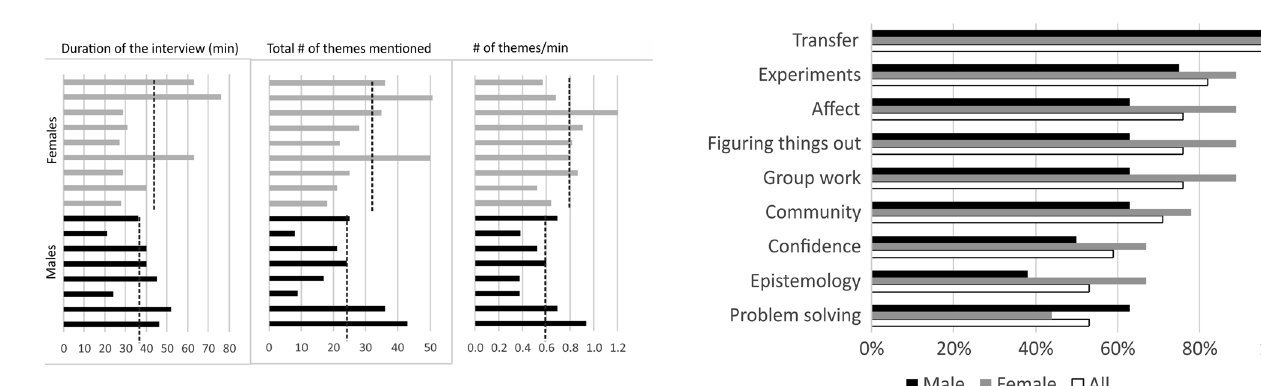
FIG. 11. Duration of the interview, the number of themes, and time frequency coded for each interviewee. Dashed lines show average